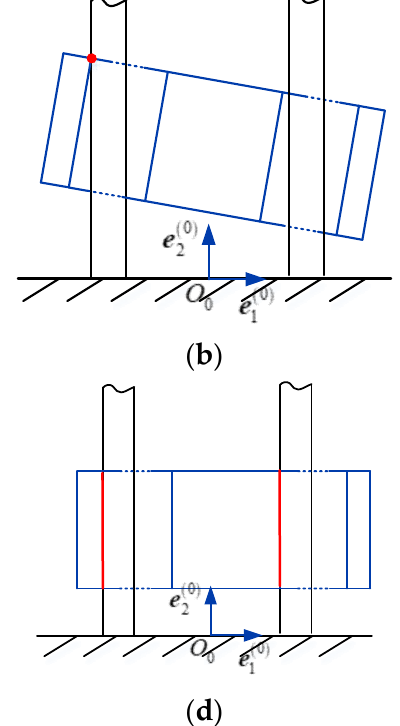
Figure 7. The contact form between the satellite and the guide bars: ( a ) Non-contact; ( b ) One-point contact; ( c ) Two-point contact; ( d ) Line contact.